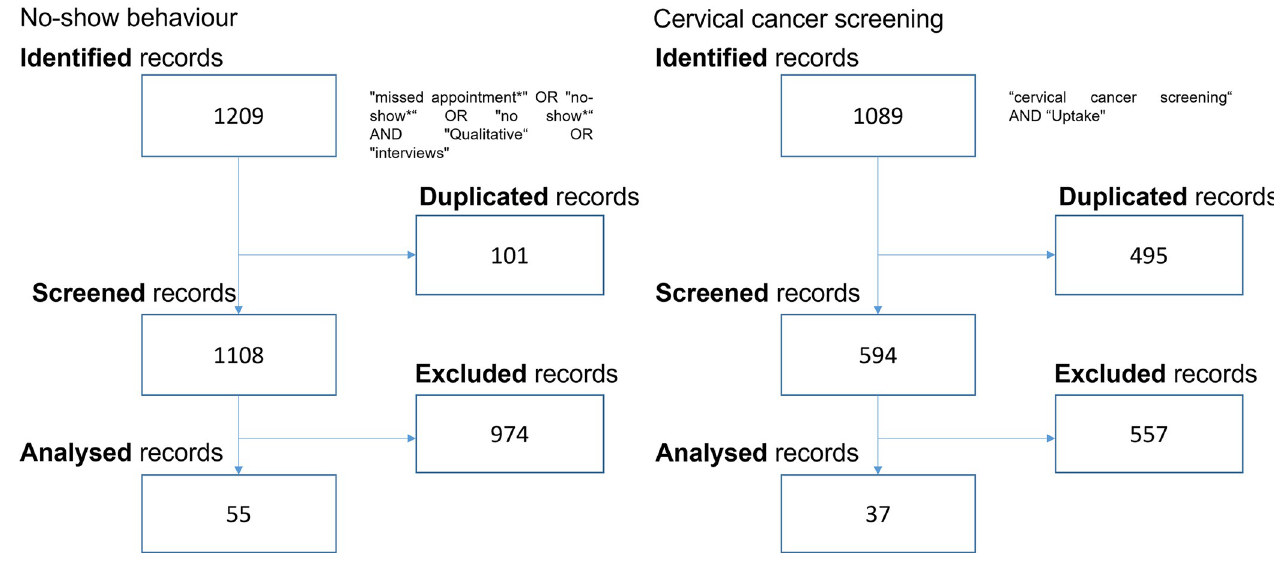
Fig 1. Literature